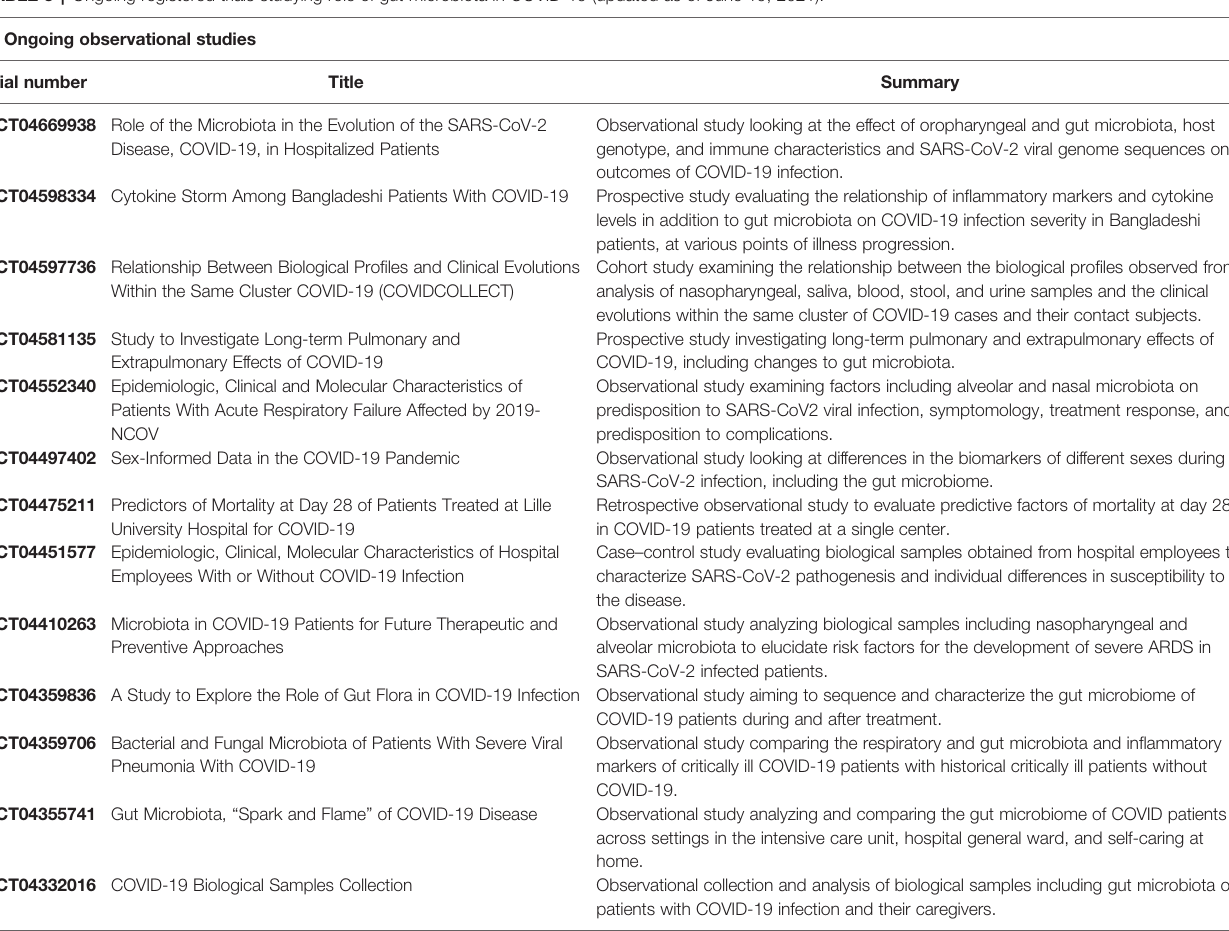
TABLE 3 | Ongoing registered trials studying role of gut microbiota in COVID-19 (updated as of June 19,